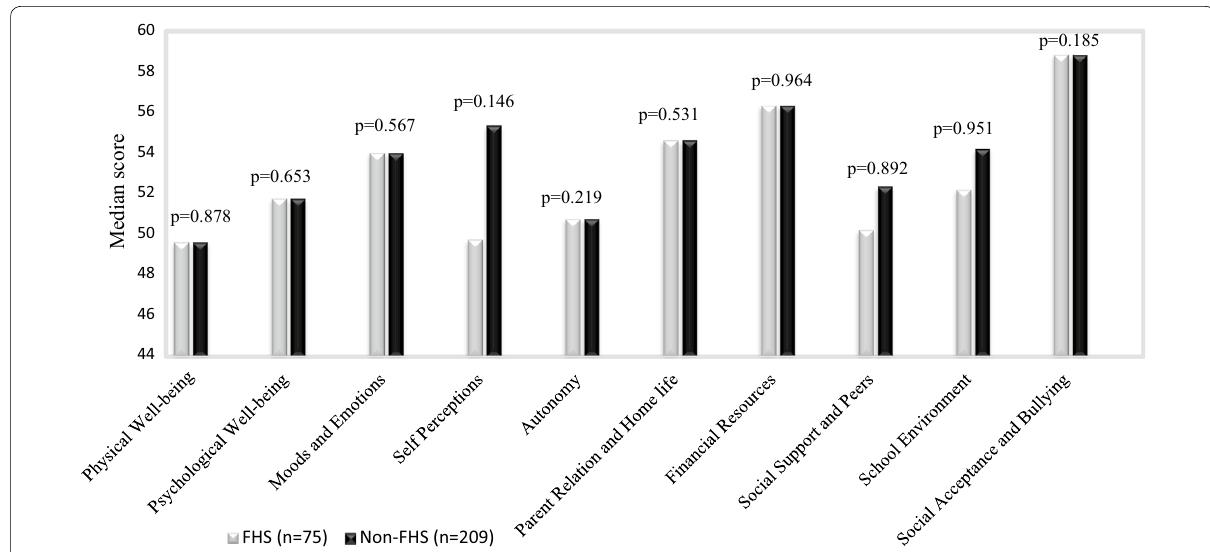
Fig. 2 Median scores in KIDSCREEN‑52 domains, among children with and without food hypersensitivity. A higher score indicate better HRQL. Differences between groups was analysed by Mann–Whitney U test